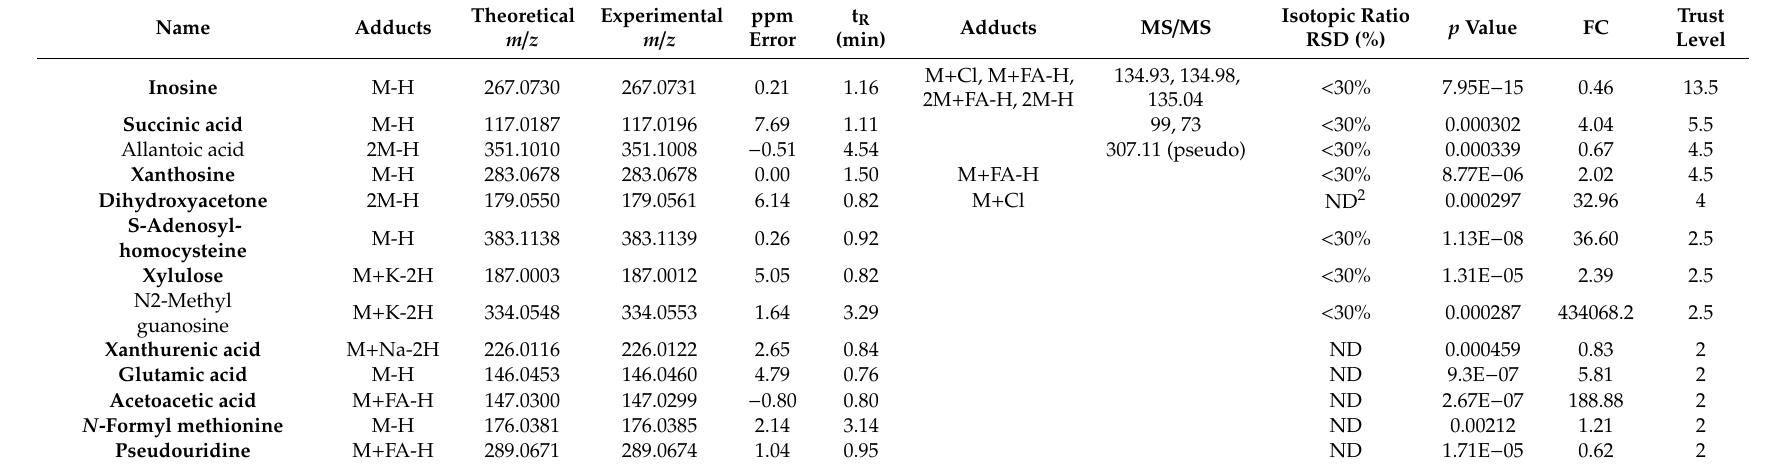
Table 4. Melanoma-derived metabolites 1 identified via targeted screening in negative ionization, and their corresponding detected parent ions, adducts and MS / MS fragments, theoretical and experimental m / z, ppm error, retention time (t R ), isotopic ratio RSD (%), p value, Fold Change (FC) and reliability